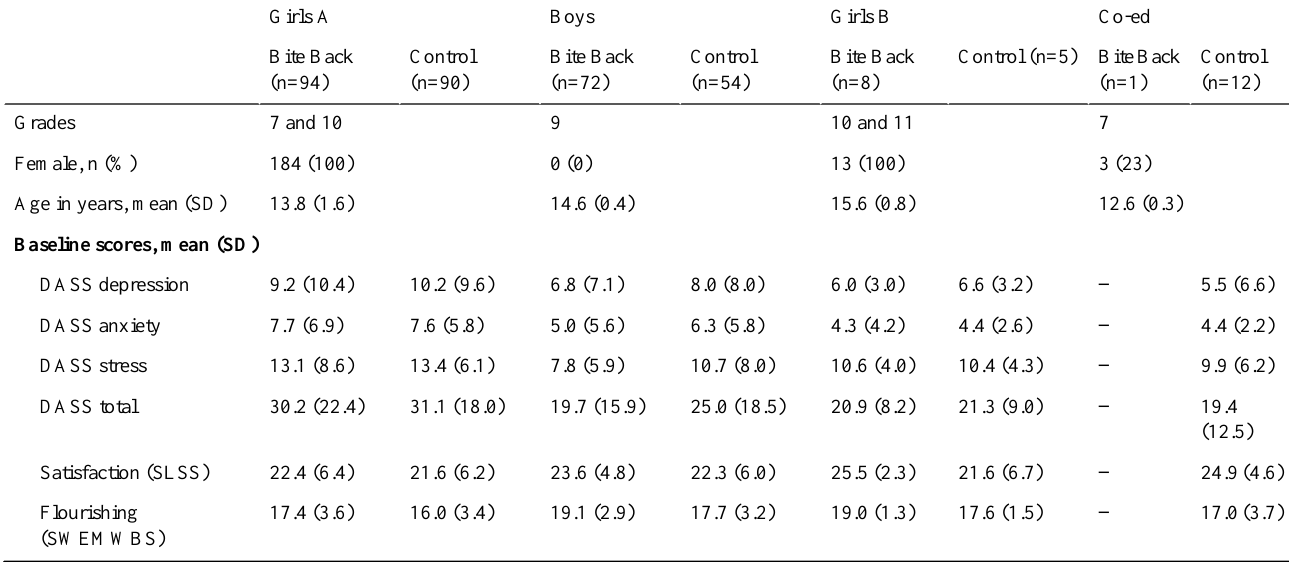
Table 1. Baseline characteristics of participants in the school